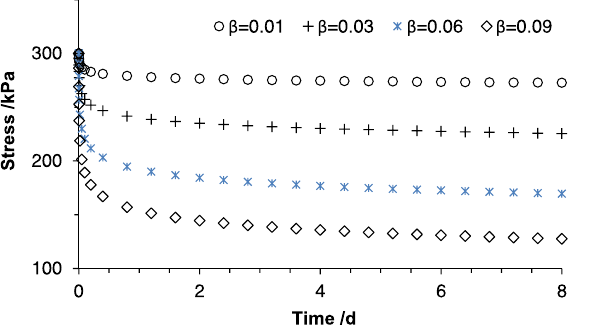
Figure 1. Time-dependent relaxation stress described by a fractional-order elementary model (Abe dashpot): σ 0 = 300 kPa and ε 0 =